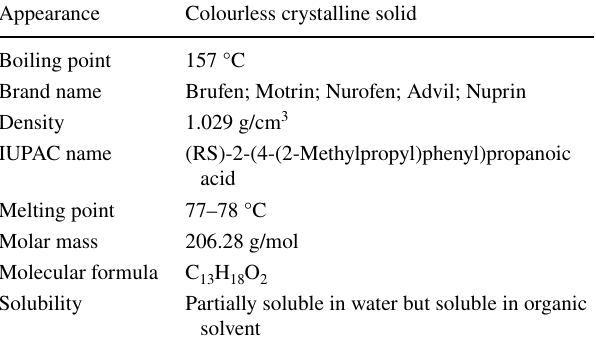
Fig. 1 Structure of ibuprofen Table 1 Physiochemical properties of